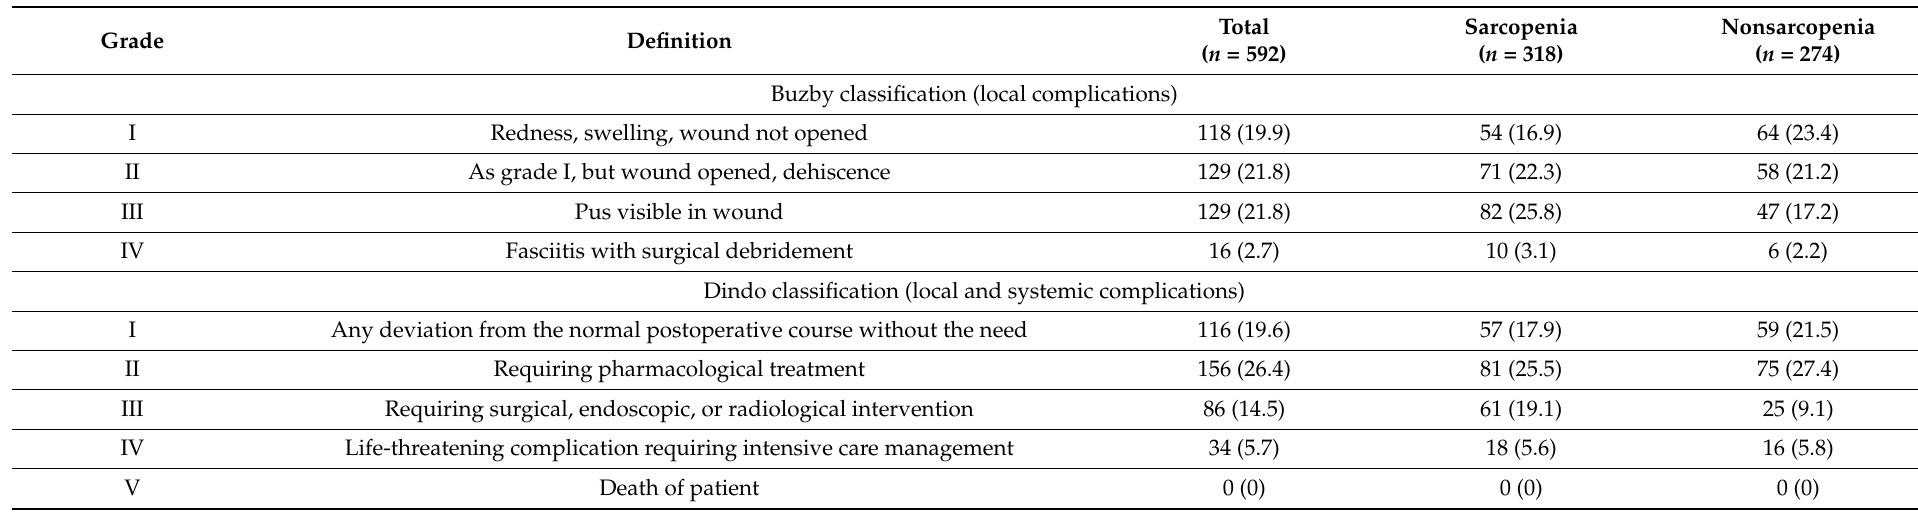
Table 2. Number and grading of complications according to the Buzby and Dindo classification.